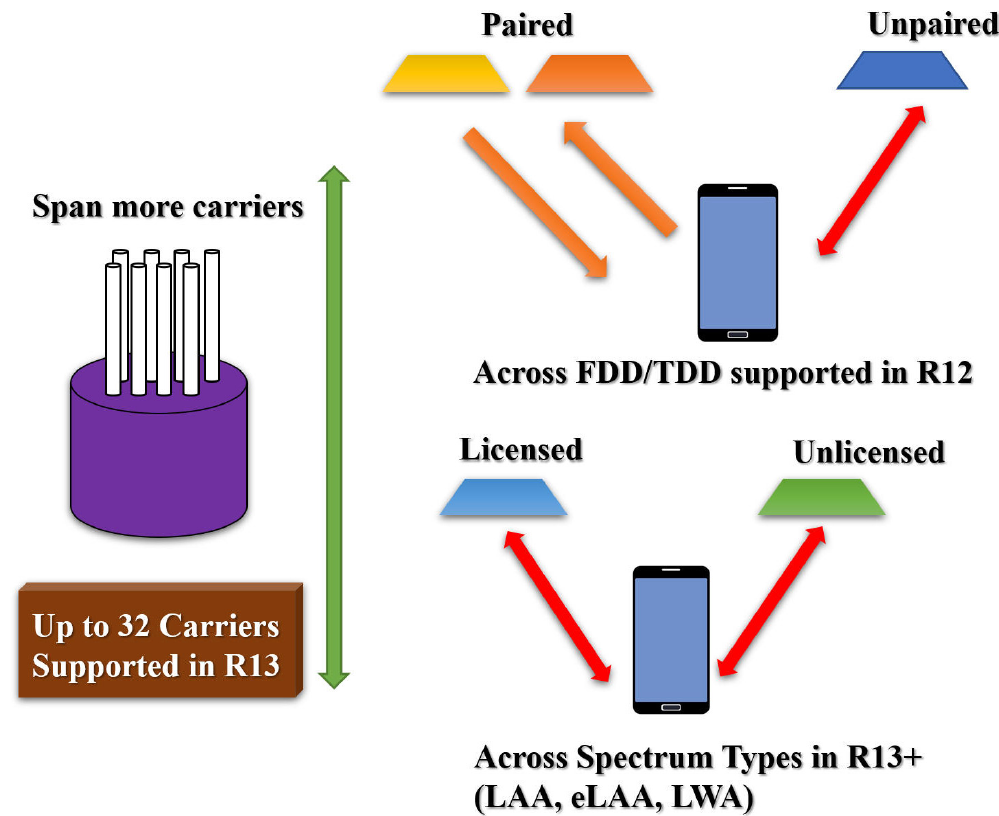
Figure 11. Fifth generation (5G) technology supports carrier aggregation technology between multiple radio